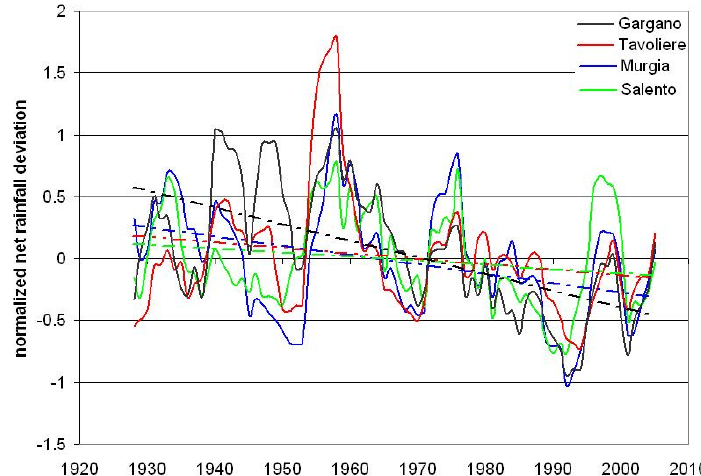
Figure 4. Normalized deviation of the five-year moving average of annual net rainfall (continuous lines) and linear trend (dashed lines) assessed for the main Apulian physiographic units. A unique color was used for each physiographic unit to plot the time series and the trend line.